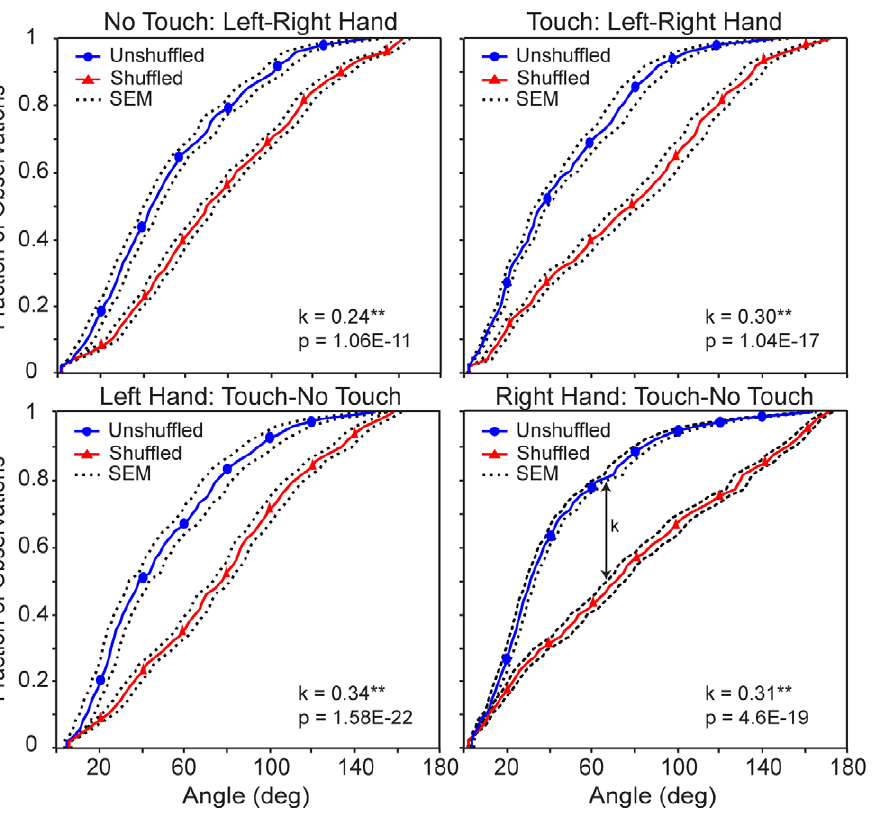
Figure 5. Average Cumulative Distribution of angles. The distributions contain the pooled data from all nine subjects for the angles obtained from the superimposed constant error vectors for both hands and conditions. The k-value represents the greatest distance between the two distributions.